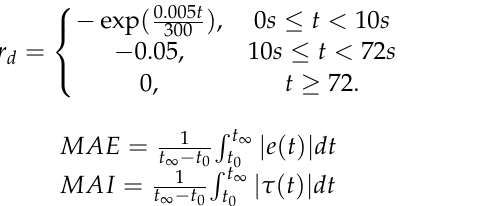
Figure 11. The error , , e e e x y ψ of comparison experiment: the proposed scheme (solid line) and